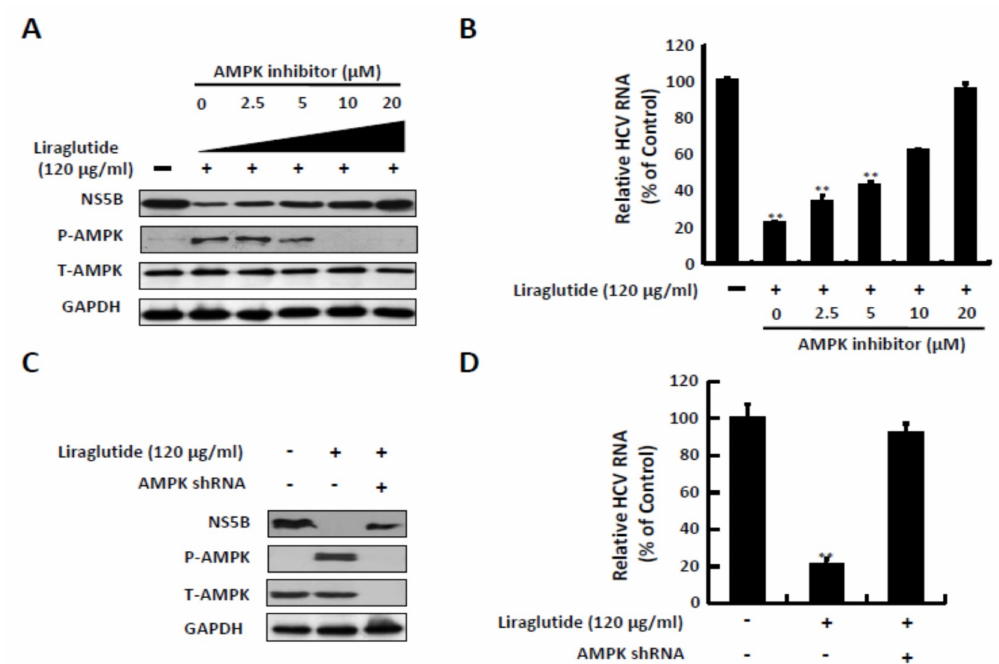
Figure 3. E ff ects of AMPK inhibitor treatment and shRNA knockdown on the anti-HCV activity of liraglutide. ( A , B ) Inhibition AMPK phosphorylation attenuated the anti-HCV activity of liraglutide. Ava5 cells were treated with liraglutide (120 µ g / mL) combined with indicated concentrations of AMPK inhibitor (Compound C) for 3 days. ( C , D ) Knockdown of AMPK expression attenuated the anti-HCV activity of liraglutide. Ava5 cells were transfected with AMPK shRNA. Subsequently, the transfected cells were treated with liraglutide (120 µ g / mL) for 3 days. The cell lysate was extracted and the protein synthesis was analyzed by Western blot using anti-HCV NS5B, anti-AMPK, anti-phospho-AMPK, and anti-GAPDH (loading control) antibodies. The total RNA was extracted and intracellular HCV RNA levels were normalized by cellular GADPH mRNA expression which were quantified by qRT-PCR. The results shown are presented as the percentage ± standard deviations (SD) from three independent experiments. * p < 0.05; ** p < 0.01, as assessed using the Student’s t -test for quantification of real-time PCR threshold values from each individual experiment and ANOVA. + with liraglutide or AMPKshRNAr added; - without liraglutide or AMPK shRNA